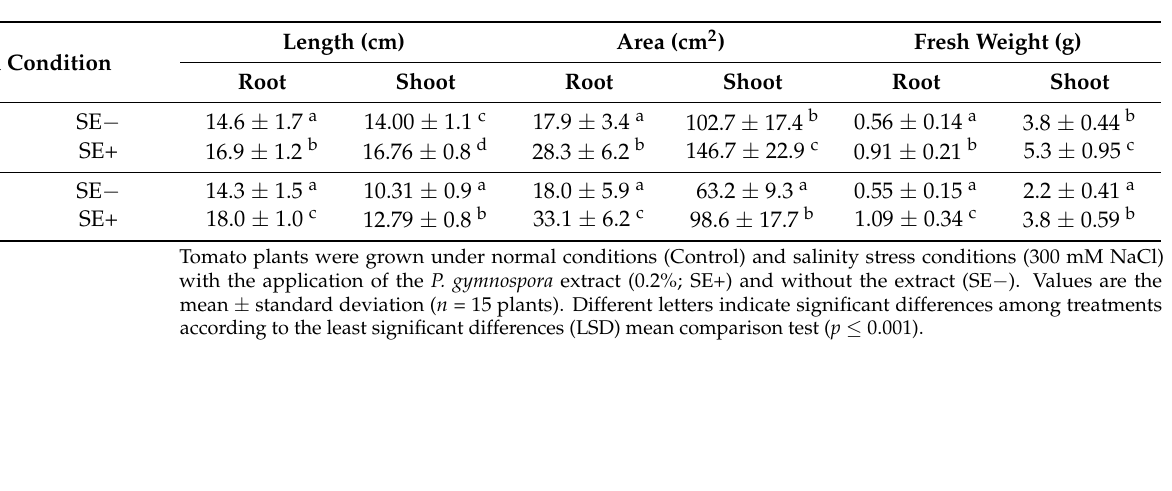
Table 3. Growth parameters of the tomato